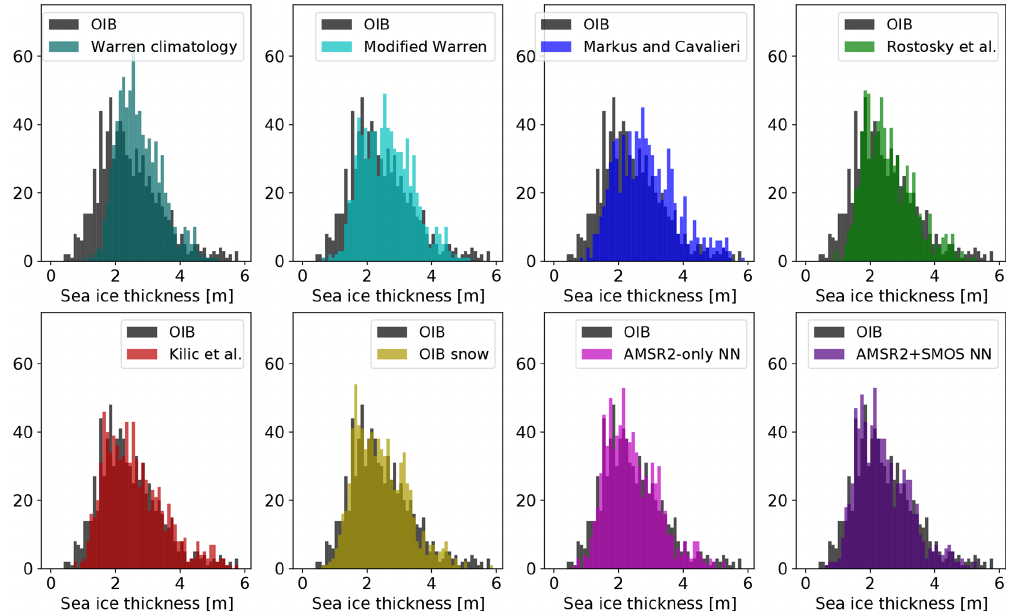
Figure 10. Distribution of OIB-measured SIT (all data) in grey versus estimated SIT using CryoSat freeboard with different snow depth algorithms in